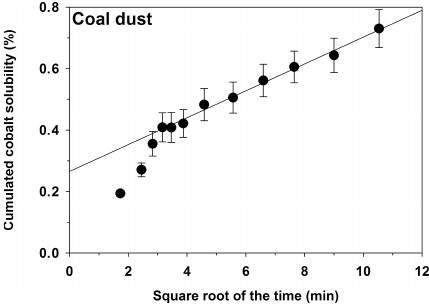
Fig. 4. Cumulated solubility of cobalt (%) as function of square root of the time ( y = 0 . 044 x + 0 . 265, R 2 = 0 .